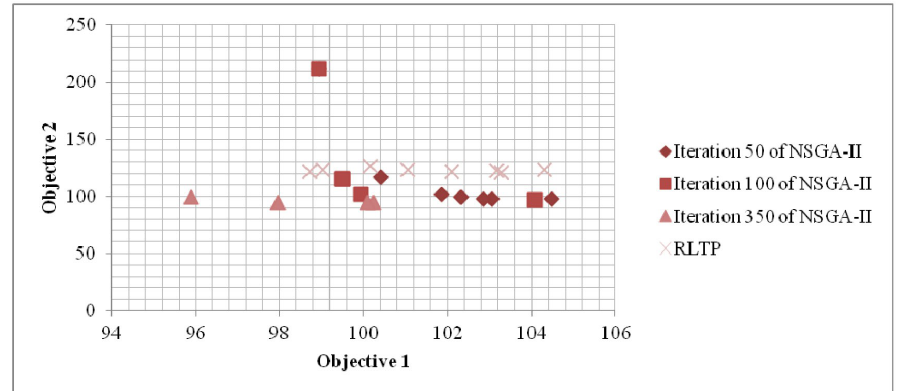
Figure 8. Solutions which are made through NSGA II and RLTP for the large scale test problem